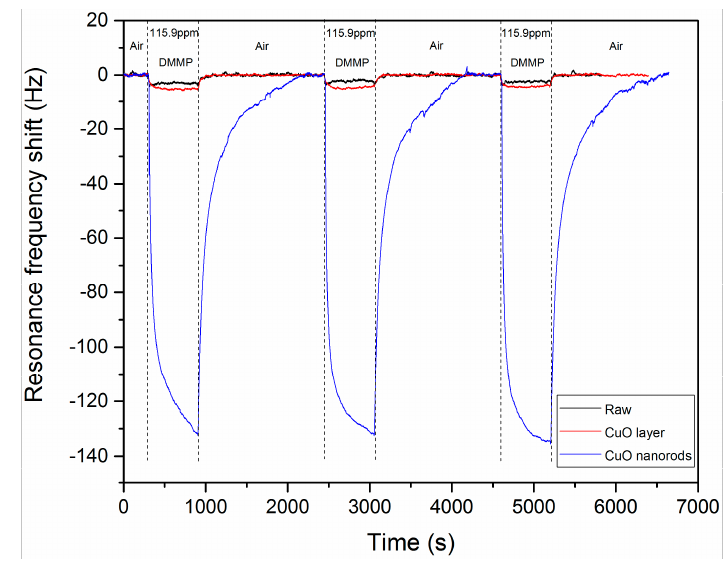
Figure 7. Resonance frequency shift of a raw cantilever (black), one covered with a CuO layer (red) and one nanostructured with CuO nanorods (blue). The cantilevers were exposed three times for 10 min to 115.9 ppm of DMMP. After each DMMP exposure, pure air is injected in the chamber containing the cantilever.